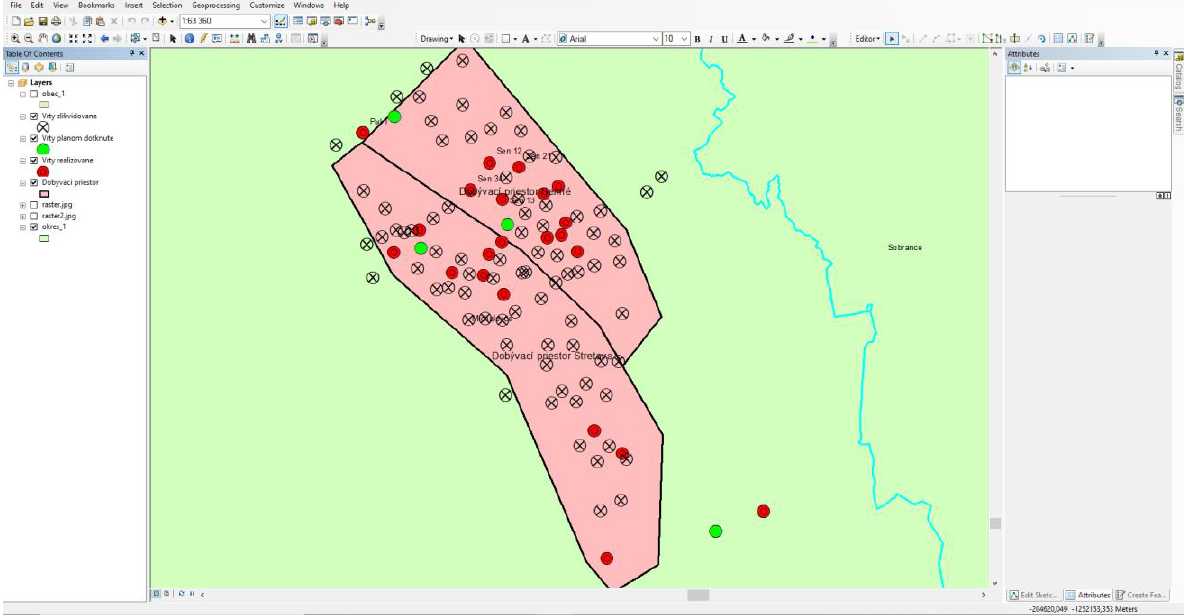
Figure 5. Creating layers for mining areas, (source: elaborated by authors).